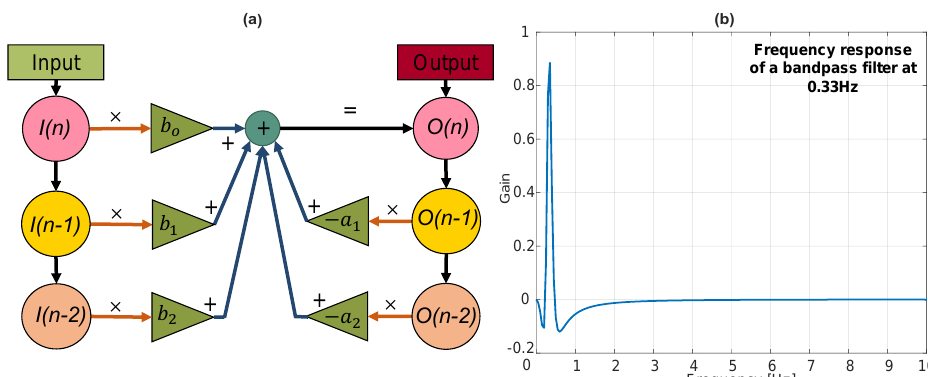
Figure 7. Band-pass bi-quadratic filter. The diagram ( a ) depicts the linear flow of the biquad filter, where the output O ( n ) at time instant n is determined by the two previous input I and output O values. Instead, a gain vs. frequency plot of a biquad band-pass filter obtained for a Q of of 20, over an Fc of 0.33 Hz, is shown as a reference in ( b